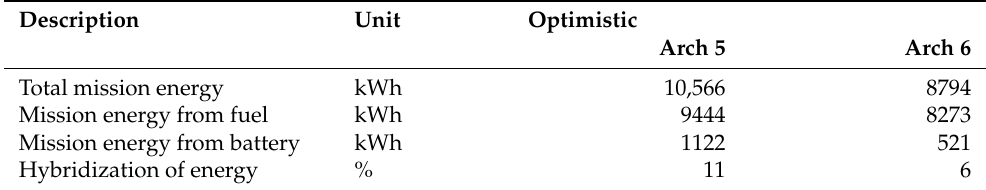
Table 13. Results on energy from the initial sizing for Architecture 5 and 6. Description Unit Optimistic Arch 5 Arch 6 Total mission energy kWh 10,566 Mission energy from fuel kWh 9444 Mission energy from battery kWh 1122 521 Hybridization of energy %